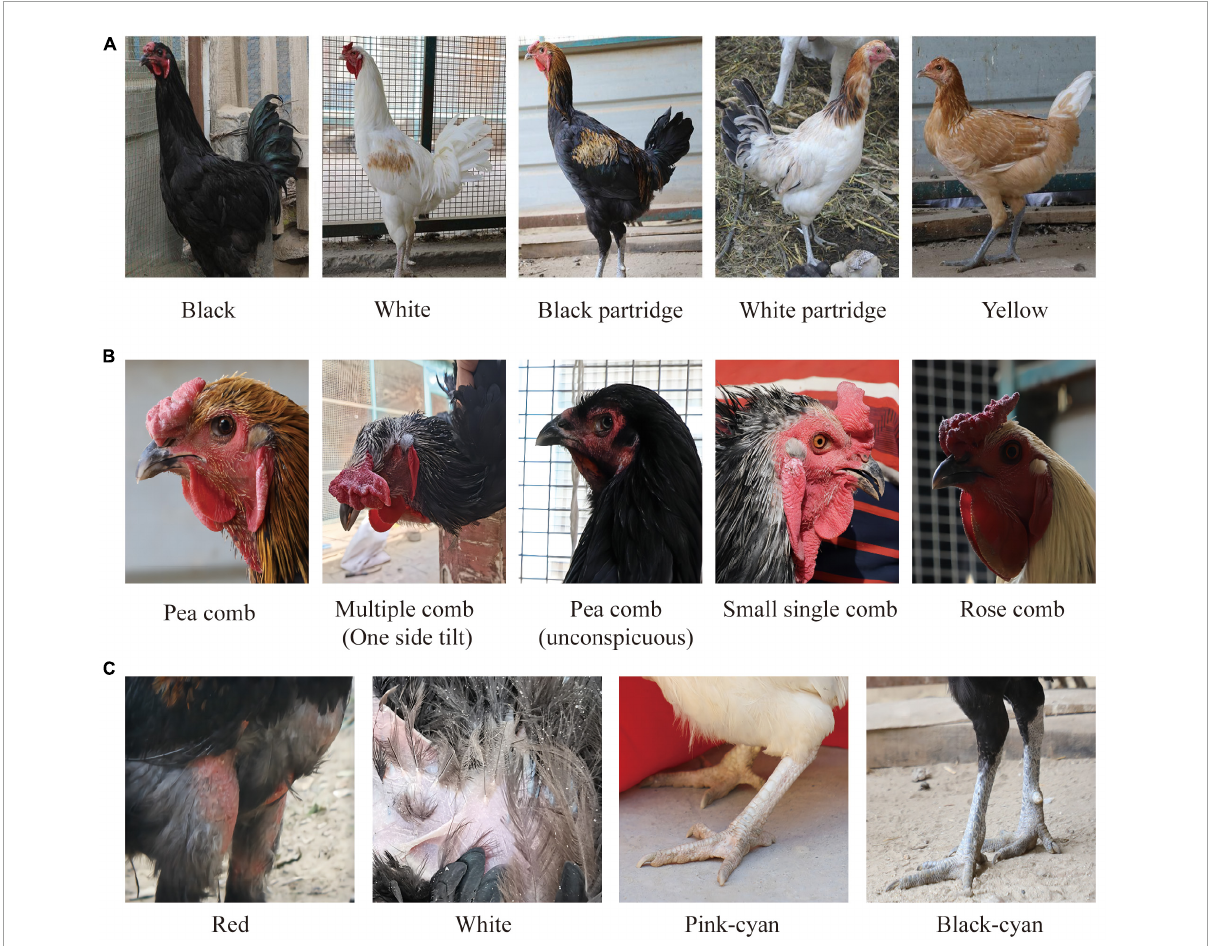
FIGURE3 Images of the morphological characteristics observed in the Anjian chickens. (A) Dominant plumage colors; (B) main comb shapes and head characteristics; (C) skin and shank